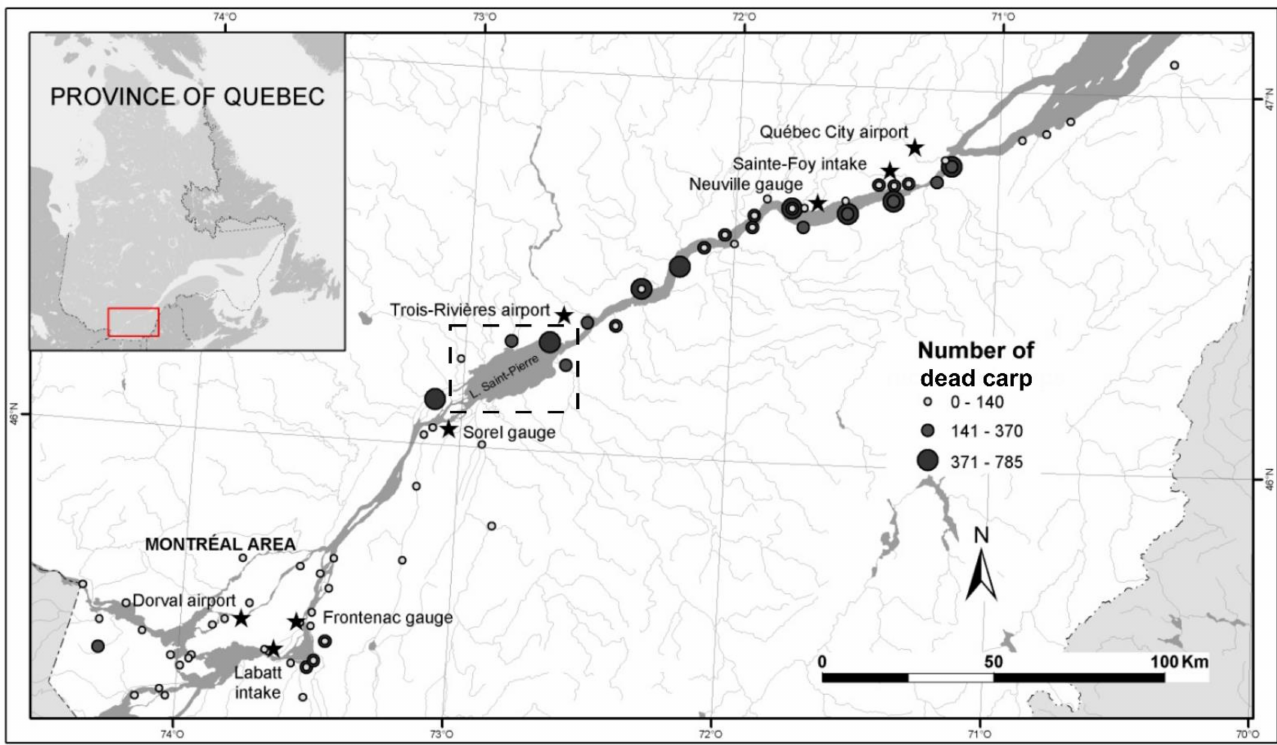
Figure 1. The freshwater course of the St. Lawrence River: locations where more than 25,000 dead common carp were collected during the mortality event of 2001 (adapted from Ouellet et al., 2010). The modeling results are shown for the Lake St. Pierre (dotted box